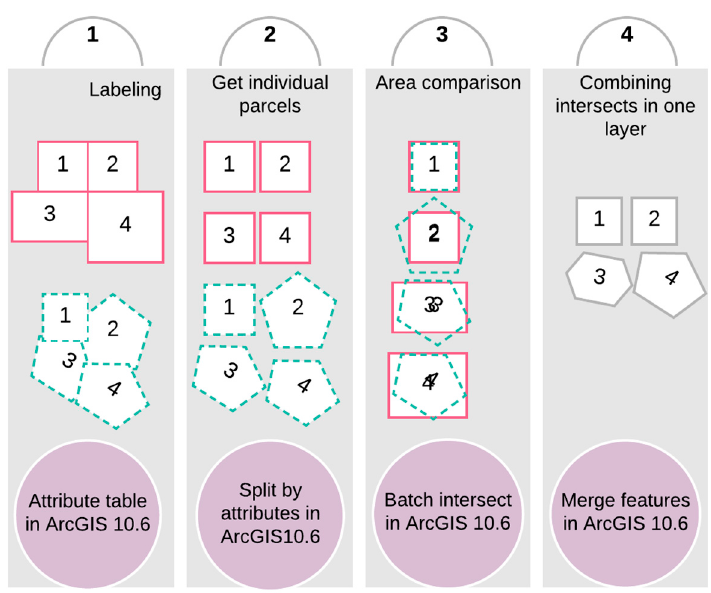
Figure 4. Implemented framework for computing geometric discrepancies.